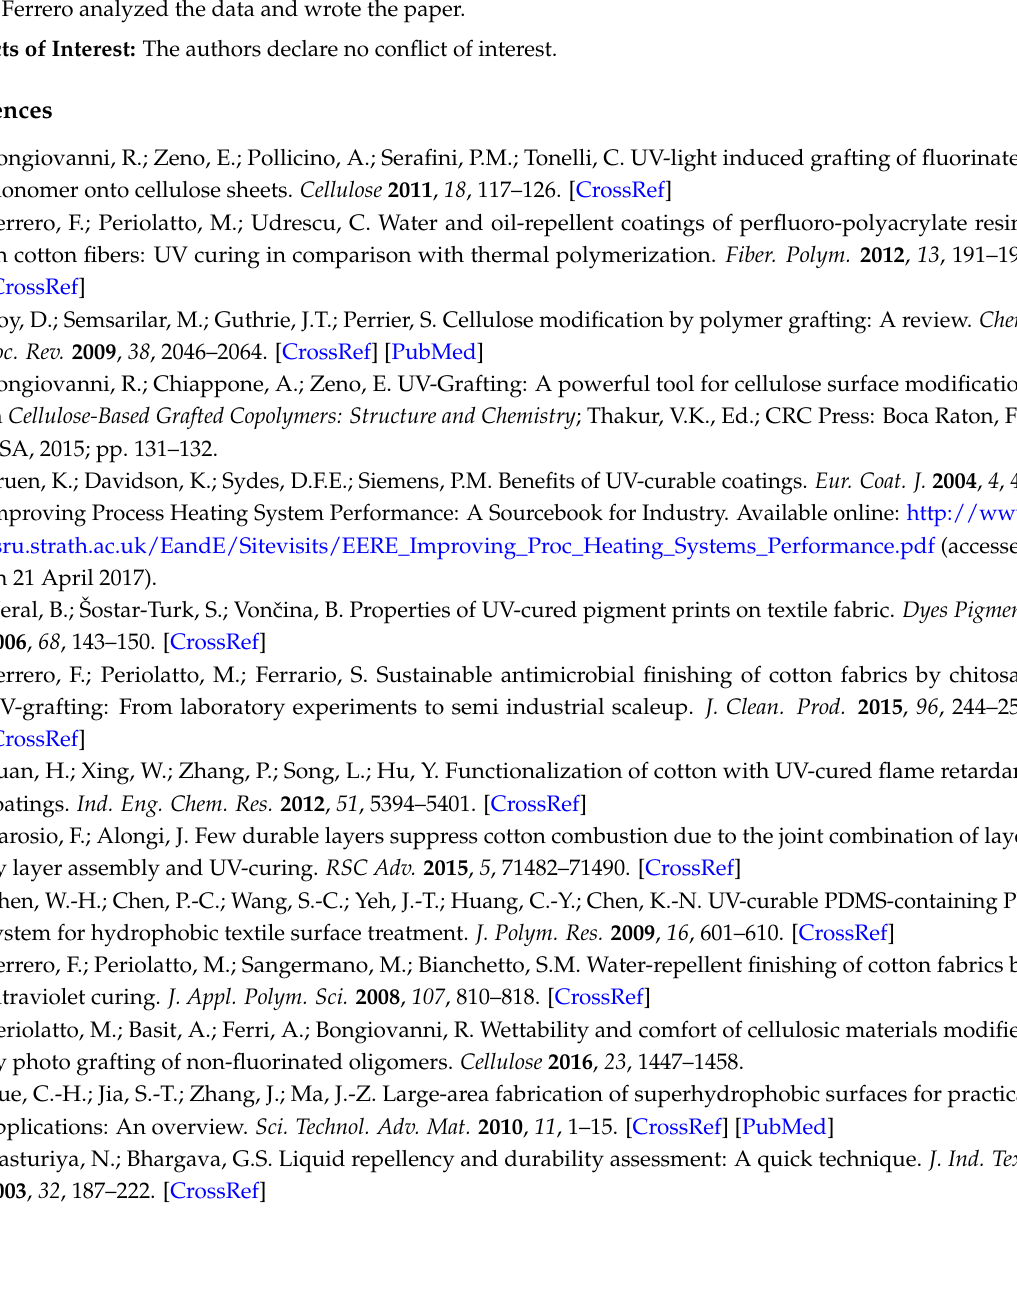
water CA on Pymasil-treated samples, Figure S7: Main effect plot for water CA on Pymasil-treated samples, Figure S8: Marginal Plot for ∆ E Datacolor measurements, Figure S9: Main Effects Plot for Datacolor measurements, Figure S10: Interaction Plot for Datacolor